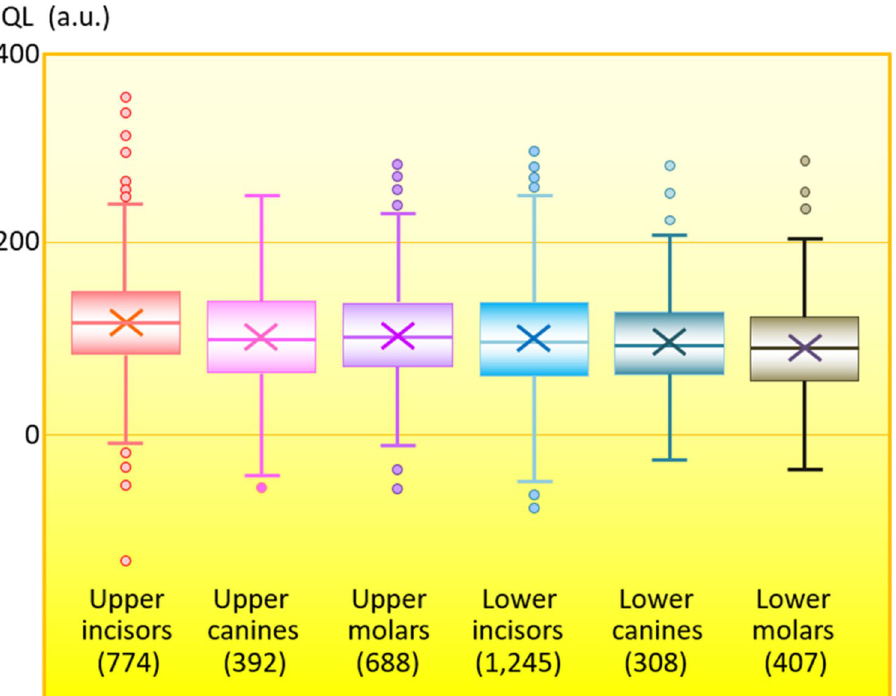
Figure 4. Quantum levels (QL) of various types of teeth. a.u.: arbitrary units. The QL is the highest in the upper incisors ( p < 0.01). Parentheses show numbers of